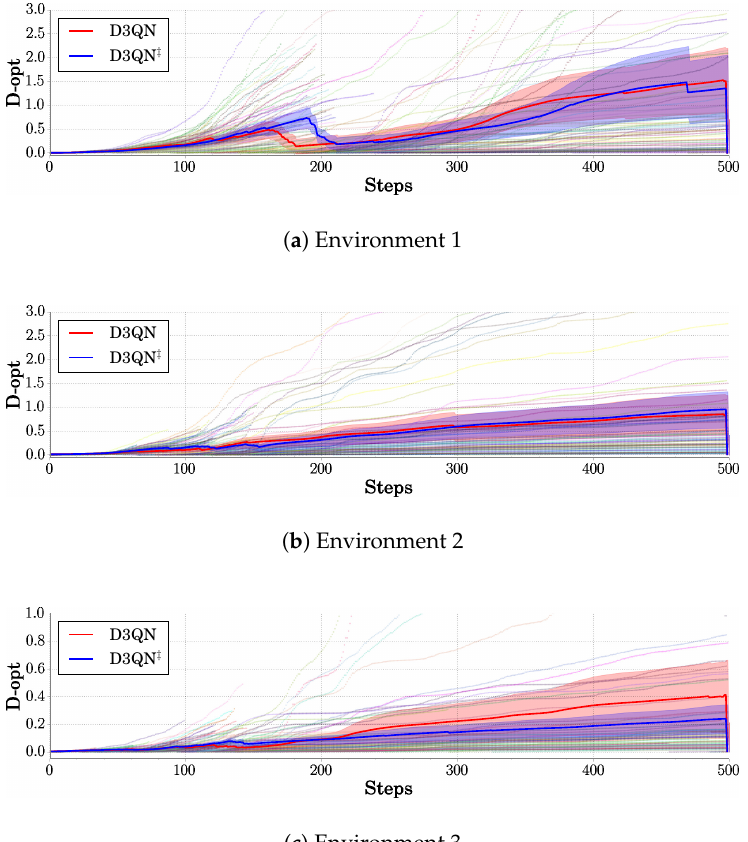
Figure 6. Evolution of the D-optimality criterion during evaluation for the agents trained with (D3QN, red) and (D3QN ‡ , R aug